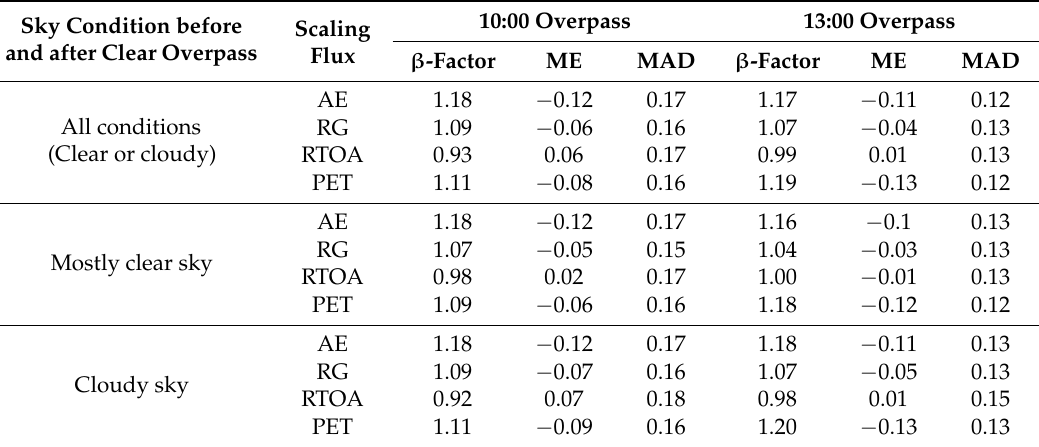
Table 3. β -factor (Equation (4)), Median Error (ME) and Median Absolute Deviation (MAD) between simulated and measured daytime ET in mm per day accounting for all the sites. Simulated daytime values were derived from ET measurements at 10:00 and 13:00 and different scaling variables: Available Energy (AE), Observed surface incoming SW radiation (R G ), Simulated TOA SW radiation (R TOA ) and potential evapotranspiration (PET). Results account for clear sky conditions at satellite overpass time and three different sky conditions during daytime: All conditions (clear or cloudy), clear-sky